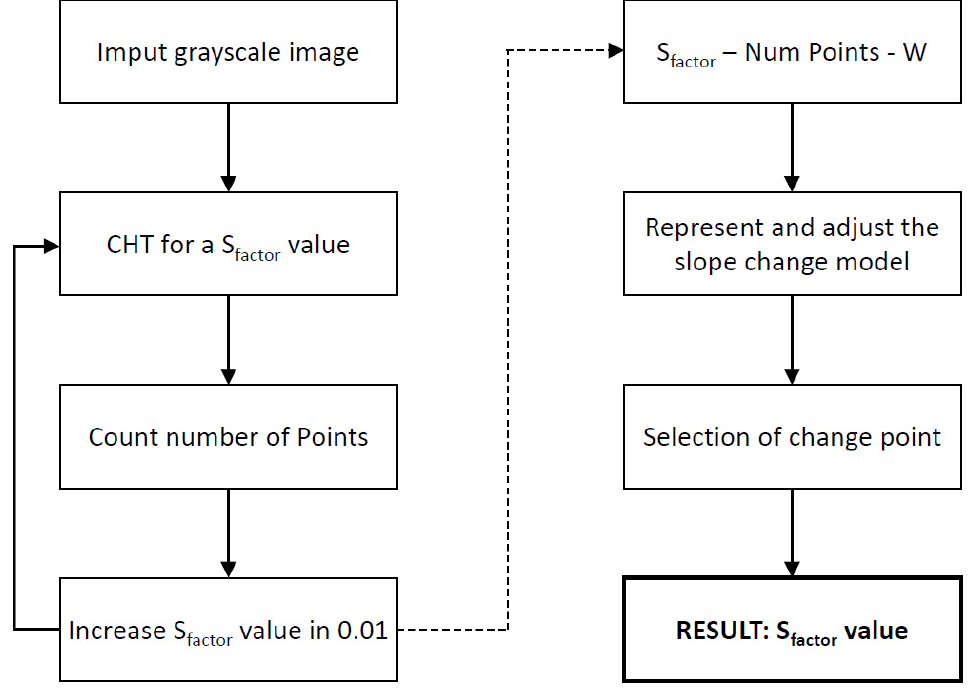
Figure 4. Process algorithm to determine the optimal